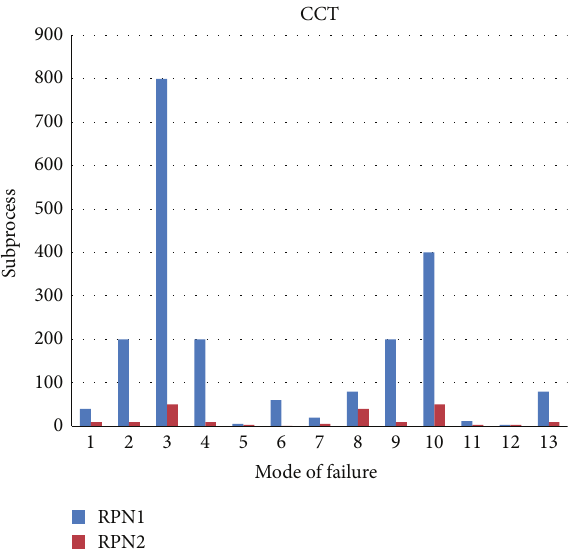
Figure 4: Bar chart for theRPN values (RPN 1: before implementing corrective actions; RPN 2: after implementing corrective